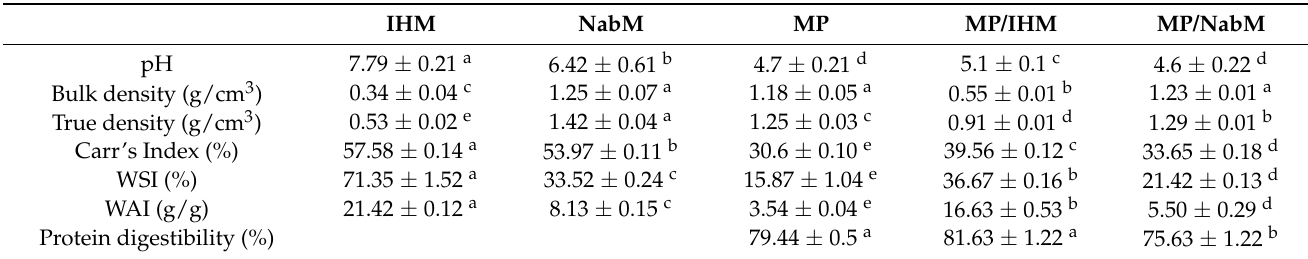
Table 1. Physicochemical and functional characteristics of MP, NabM, IHM, and